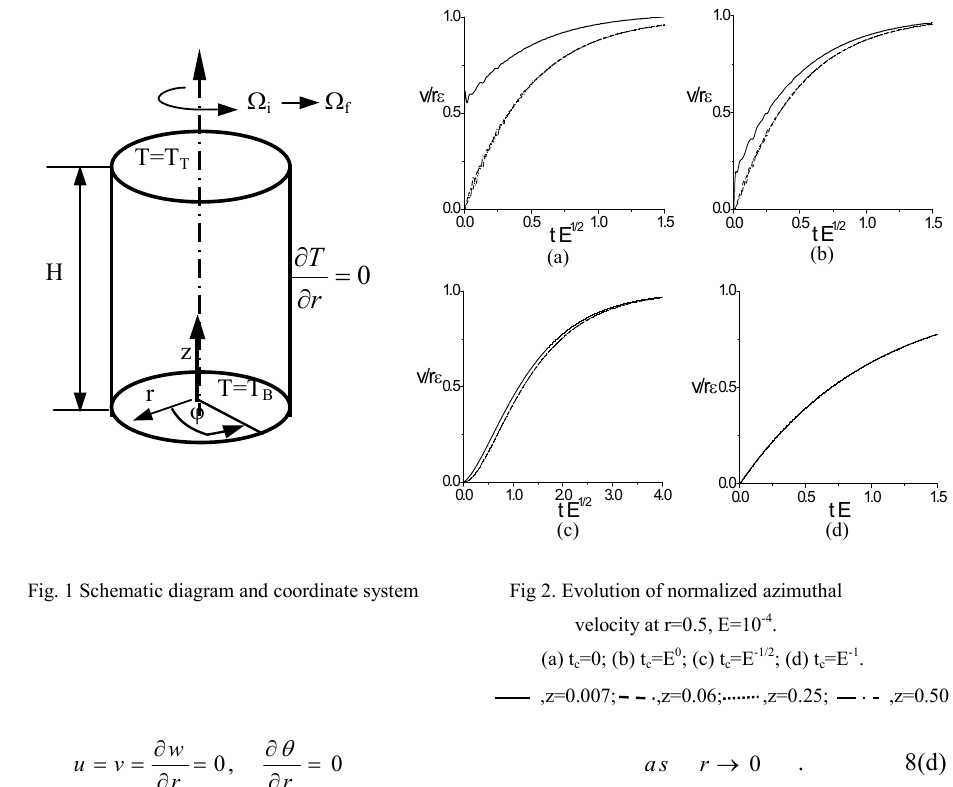
velocity at r=0.5, E=10 -4